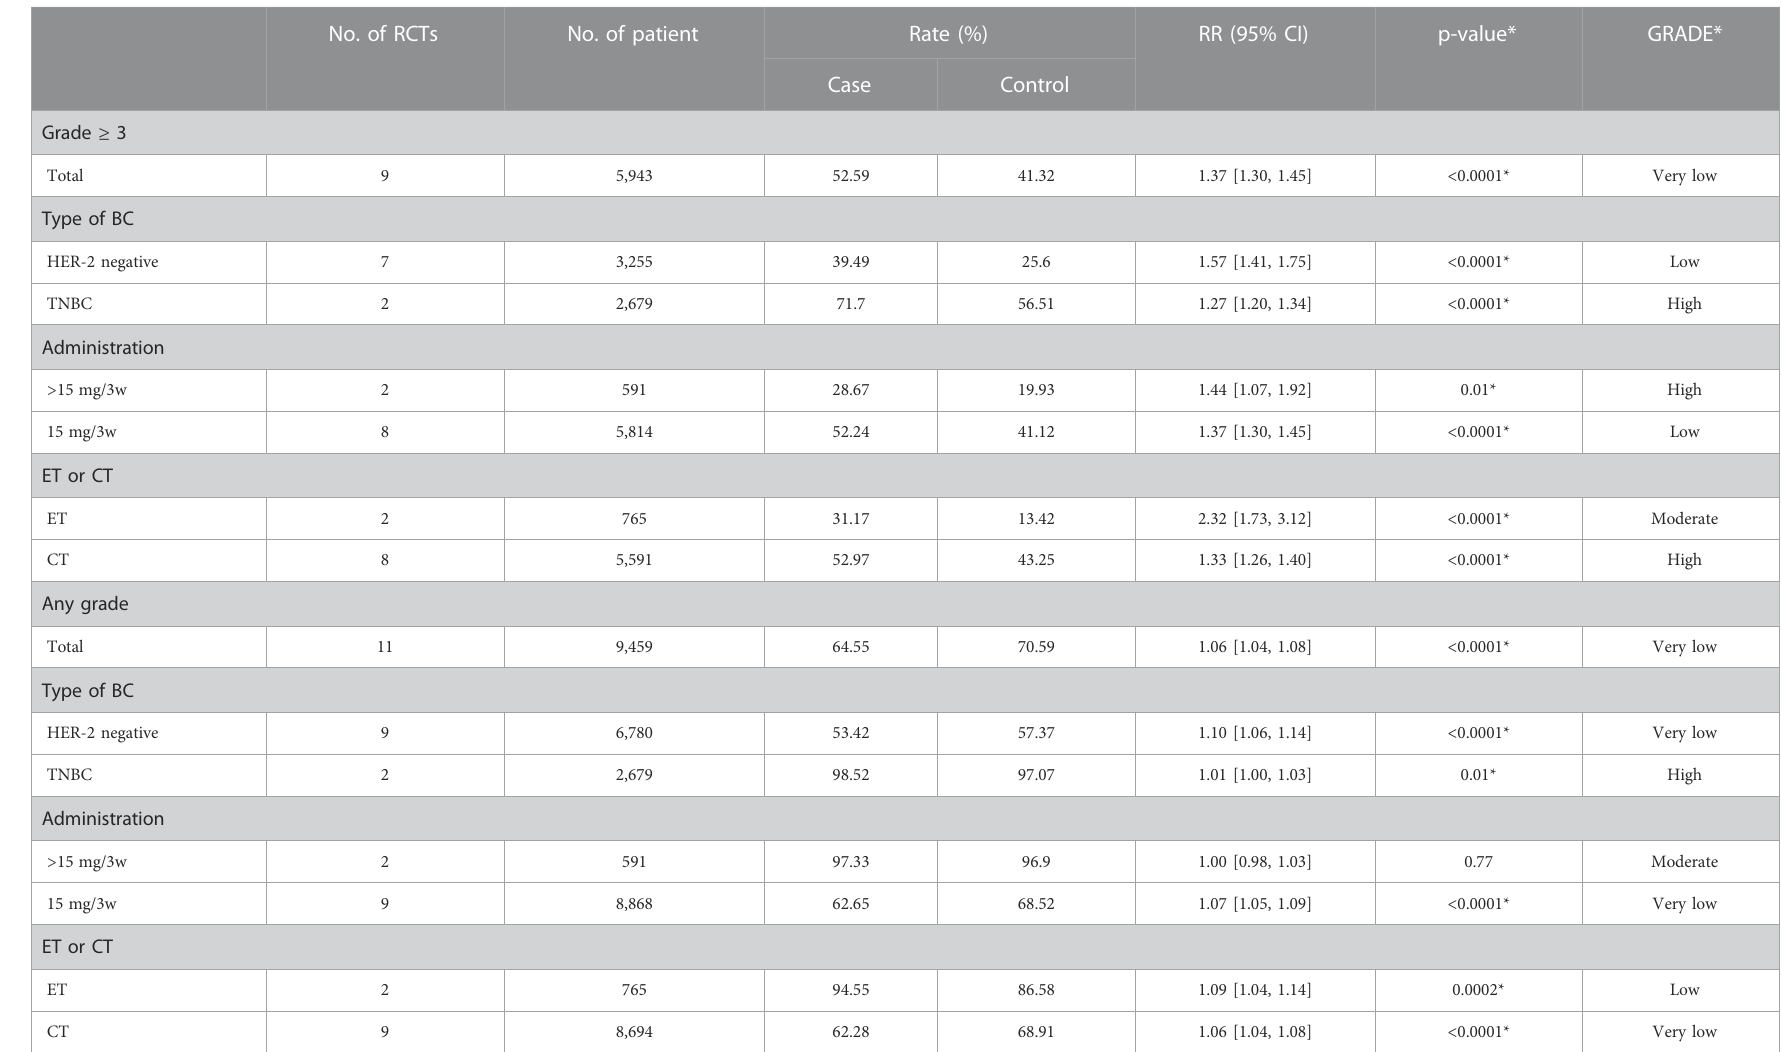
TABLE 2 Primary